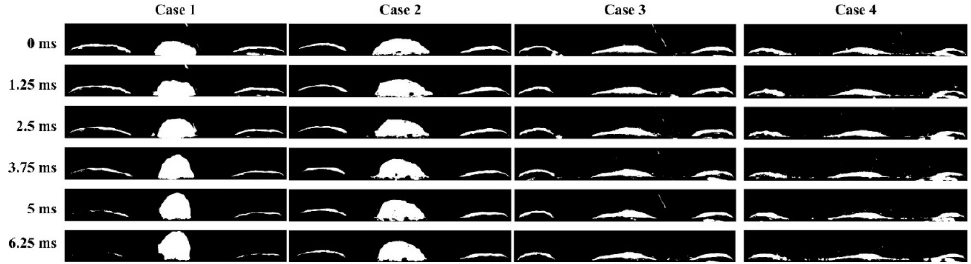
Figure 4. Temporal film topography under different experimental